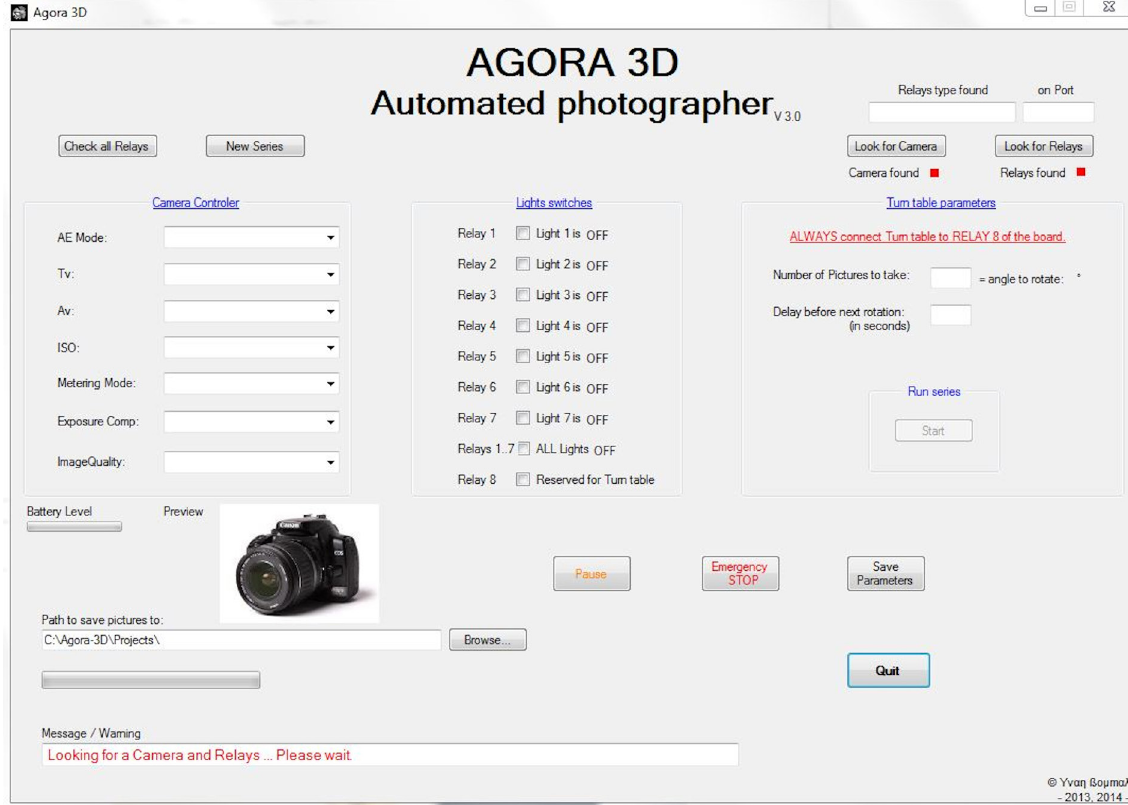
Fig. 3.5. Interface of the AGORA 3D Automated